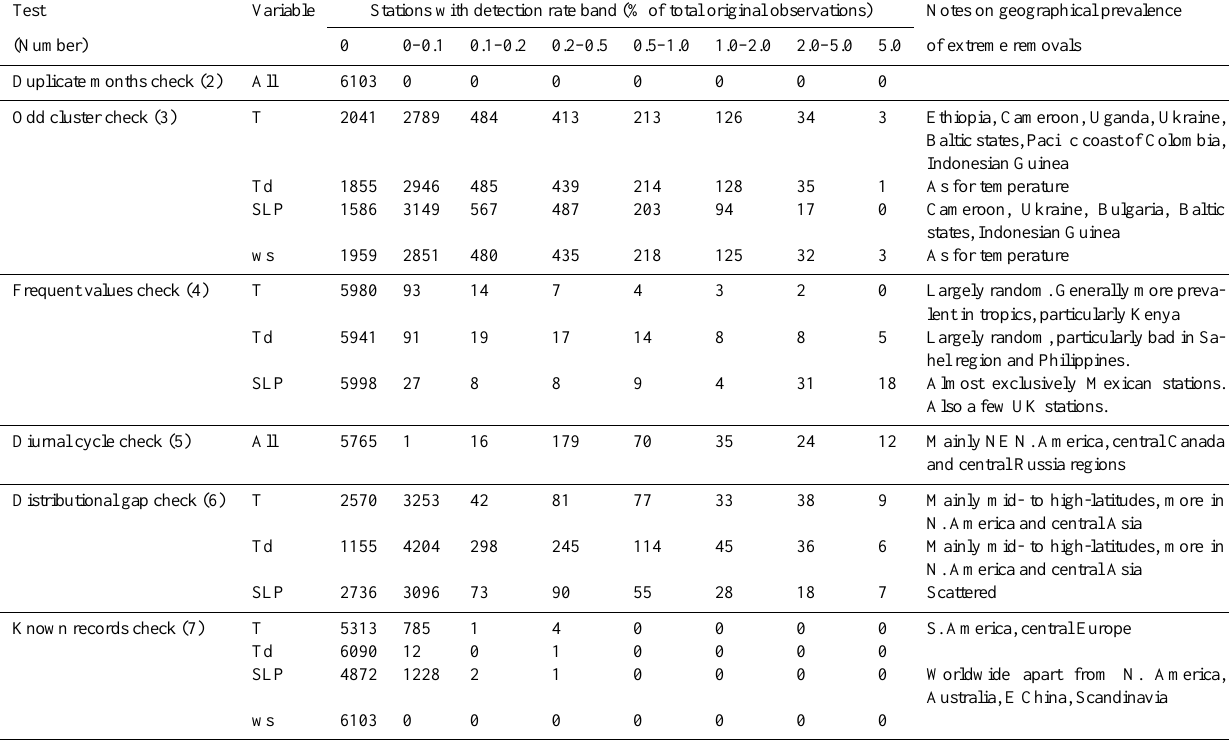
Table 6. Summary of removal of data from individual stations by the different tests for the 6103 stations considered in detailed analysis. The final column denotes any geographical prevalence. A version of this table in percent is presented in Table